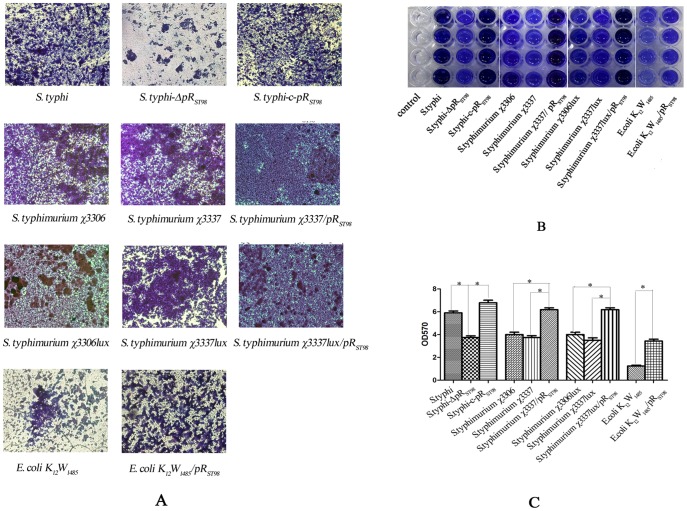
Comparison of BF developed by different bacteria.(A) Different bacteria cultured in vitro for 3 d in microtiter plates at 30°C and stained by crystal violet (400×). (B) Different bacteria cultured in vitro for 3 d in 96-well plates at 30°C and stained by crystal violet. (C) Optical density of cultures measured at a wavelength of 570 nm (OD570) after crystal violet staining (*p <0.05).